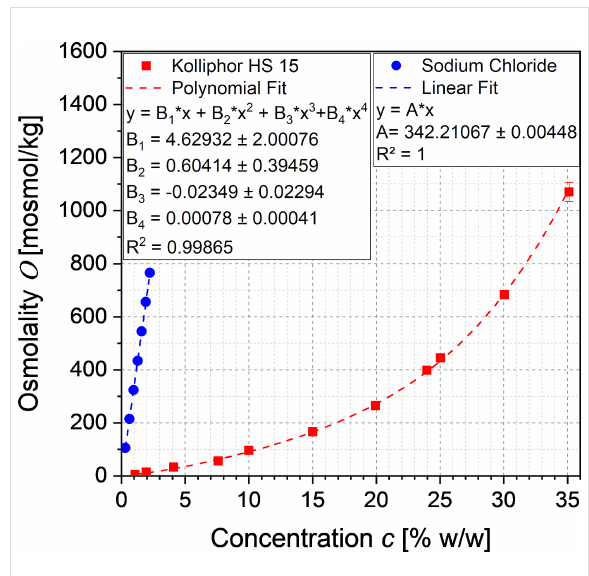
Figure 3: Ideal osmolality of aqueous sodium chloride solutions after Ph. Eur. 2.2.35 and experimental osmolality of aqueous dissolved Kolliphor HS 15, fitted according to Equation 1 and Equation